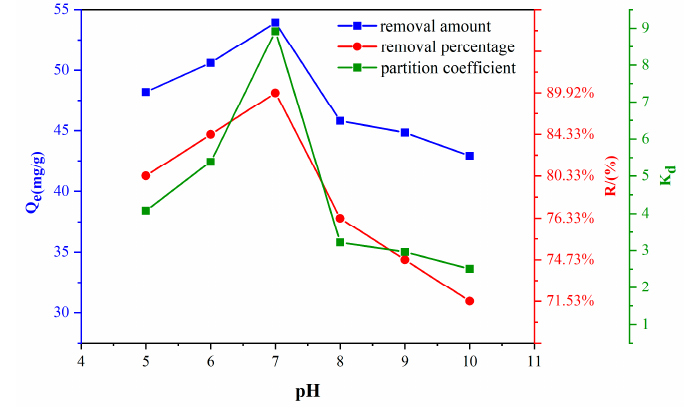
Figure 7. Effect of pH on adsorption of GO by iron tailings.